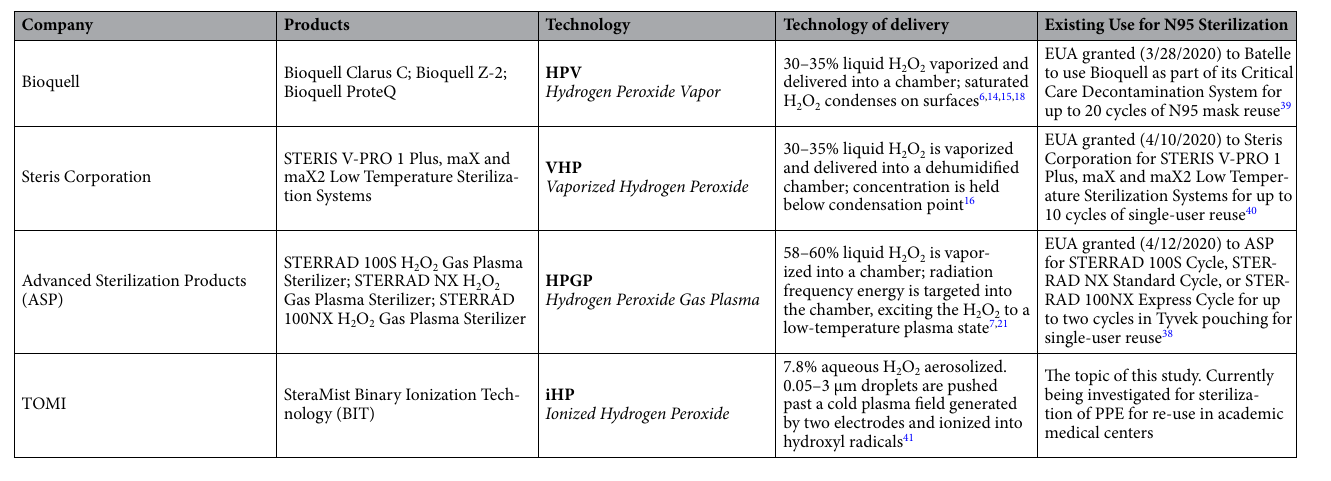
Table 1. Comparison of commercial sterilization technologies that use vaporized and ionized hydrogen